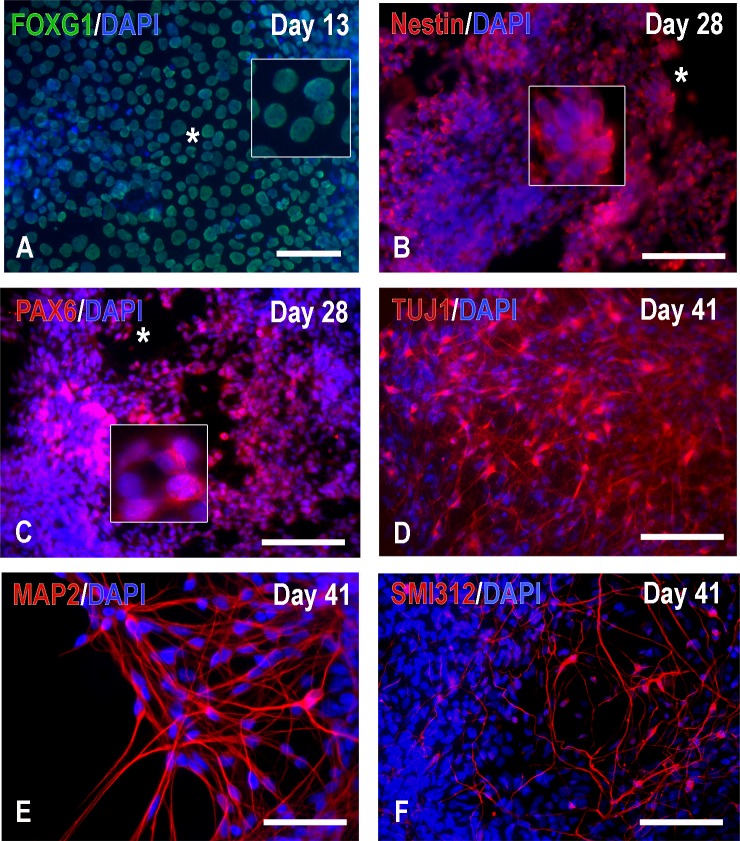
Characterization of H9-derived hNPs by immunocytochemistry at an early stage.Neuronal progenitors were plated on matrigel-coated ibidi chambers or PDL/Laminin coated-12 mm coverslips on day 23. Cells were fed with NDM every 2 days. At Days 13–28, most H9-derived cells expressed the primary progenitor and telencephalon marker FOXG1 (A) and the neural stem cell markers nestin (B) and PAX6 (C); cells immunoreactive for the stem cell marker Oct4 were rare (data not shown). On Day 41 (E-F), some cells were TUJ1, MAP2 and SMI-312 positive but vGAT, vGLUT1 and synapsin 1 signals were absent (data not shown). Scale bars: A, 25μm; B-D and F, 100μm; E, 50μm.